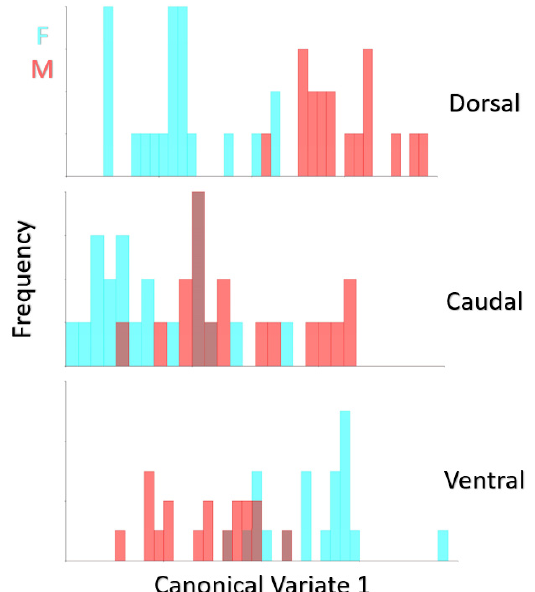
Figure 6. Frequency of distribution for canonical variate 1 of female quail (n:18) and male quail (n:21). ( p < 0.0001 from 10,000 permutation rounds for Procrustes distances among groups).